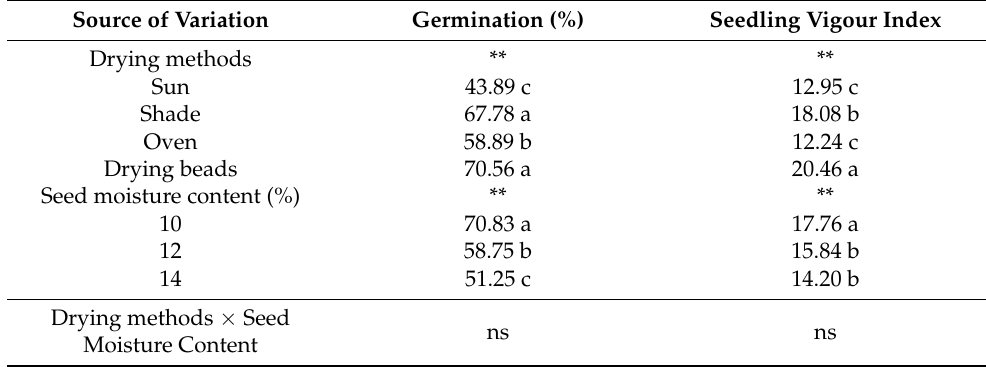
Table 2. Lablab bean seed germination percentages after drying using different